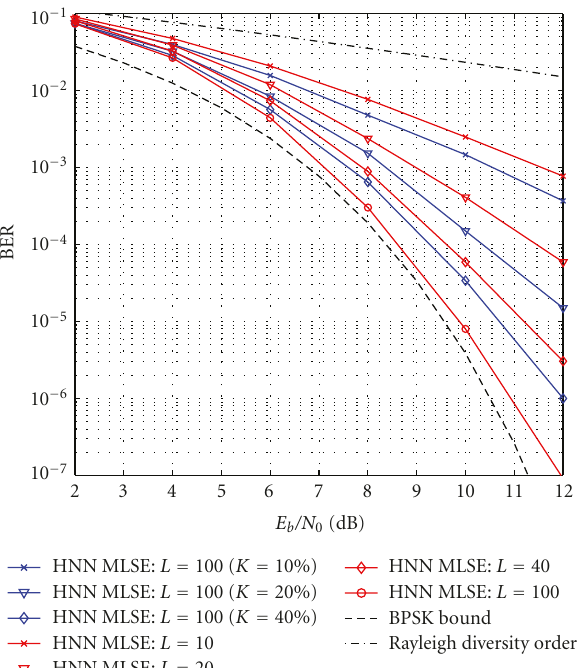
Figure 19: BPSK HNN MLSE performance in sparse channels with constant diversity.